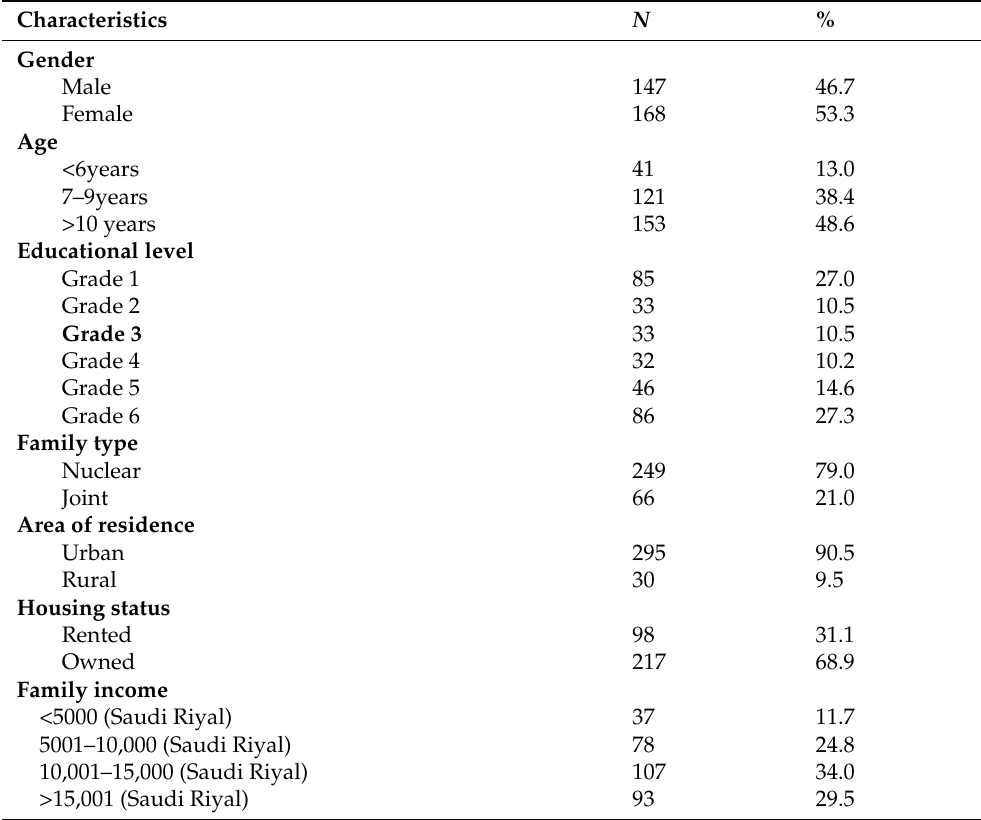
Table 1. Demographic and personal characteristics of